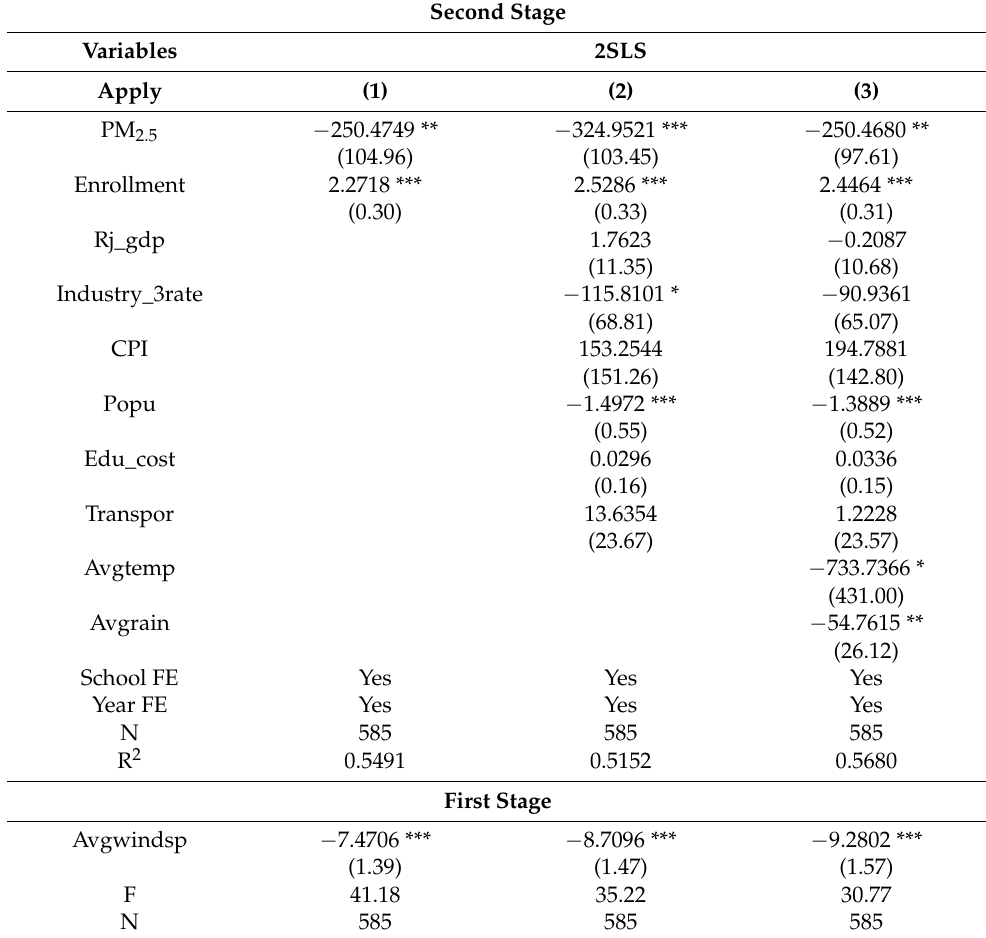
Table 3. Impact of air pollution on applicants’ number (2SLS